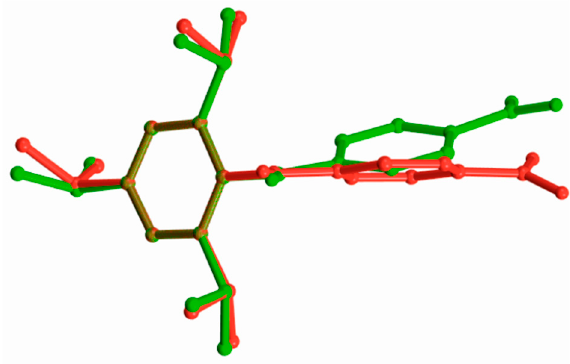
Figure 5. The A (red) and B (green) anions of compound ( 2 ) at 1.0 GPa superimposed in the C1 → C6 plane.